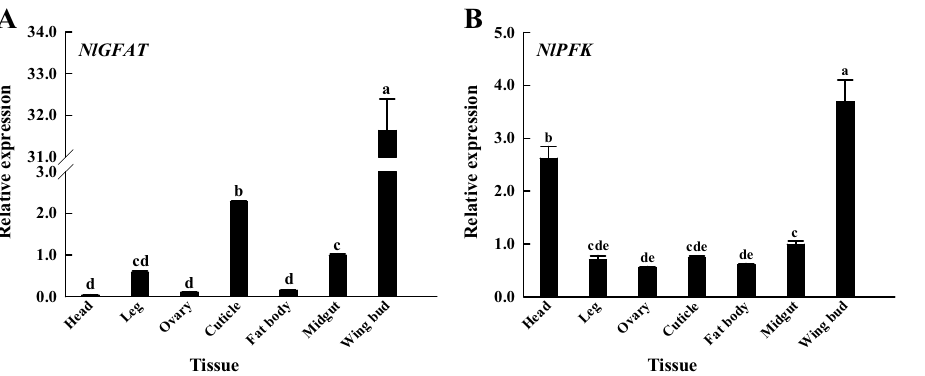
Figure 2. Expression levels of GFAT ( A ) and PFK ( B ) in seven different tissues of Nilaparvata lugens . GFAT, glutamine:fructose-6-phosphate aminotransferase; PFK, phosphofructokinase. The head, leg, ovary, cuticle, fat body, midgut, and wing bud of N. lugens used to detect the tissue expression level of genes, were evenly collected from individuals of nymphs in different instars and from adults. Gene expression levels were measured by quantitative real-time PCR with 18S RNA as the internal control. Values are means ± SE from three independent measurements. Different letters indicate significant differences according to Duncan’s test ( p <